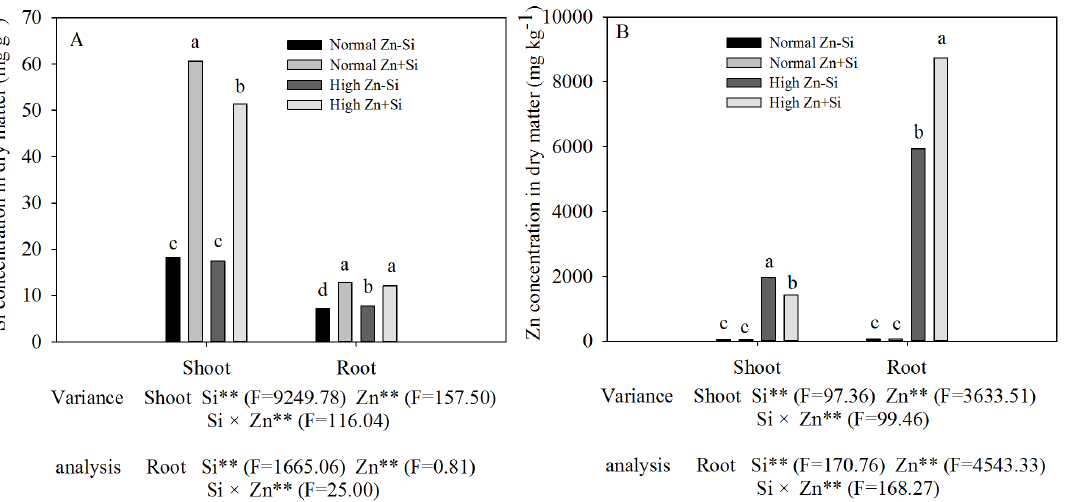
Figure 3. Si contents in dry matter of shoot and root (A) and Zn contents in dry matter of shoot and root (B) of Zn-sensitive rice ( Oryza sativa L.) cultivar grown hydroponically with either normal (0.15 m M) or high (2 mM) Zn without or with 1.5 mM Si for 72 h. Data are means ¡ S.D. of three replicates. Note:P-values indicate significance level based on two-way ANOVA. * P , 0.05, ** P , 0.01. Data followed by different letters in the shoot or root are significantly different according to ANOVA (P , 0.05).